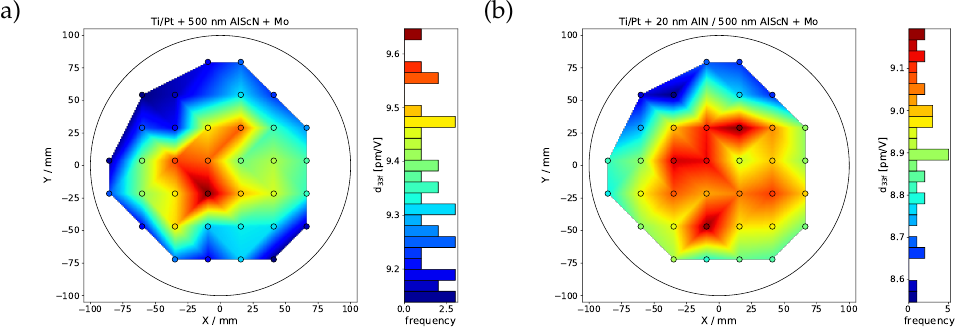
Figure 6. Measured d 33, f of ( a ) 500nm AlScN and of ( b ) 500nm AlScN with 20nm AlN seed layer on Ti/Pt sput on a wafer